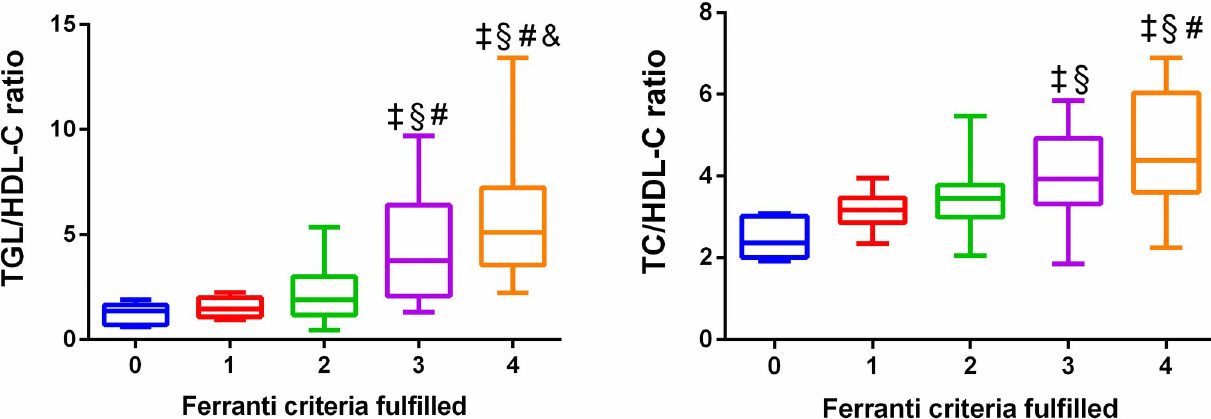
Fig 3. Levels of TGL/HDL-C and TC/HD-C ratios in relation to the number of fulfilled Ferranti criteria. ‡ showed significant difference vs 0 Ferranti criteria fulfilled; § showed significant difference vs 1 Ferranti criteria fulfilled; # showed significant difference vs 2 Ferranti criteria fulfilled; & showed significant difference vs 0 Ferranti criteria